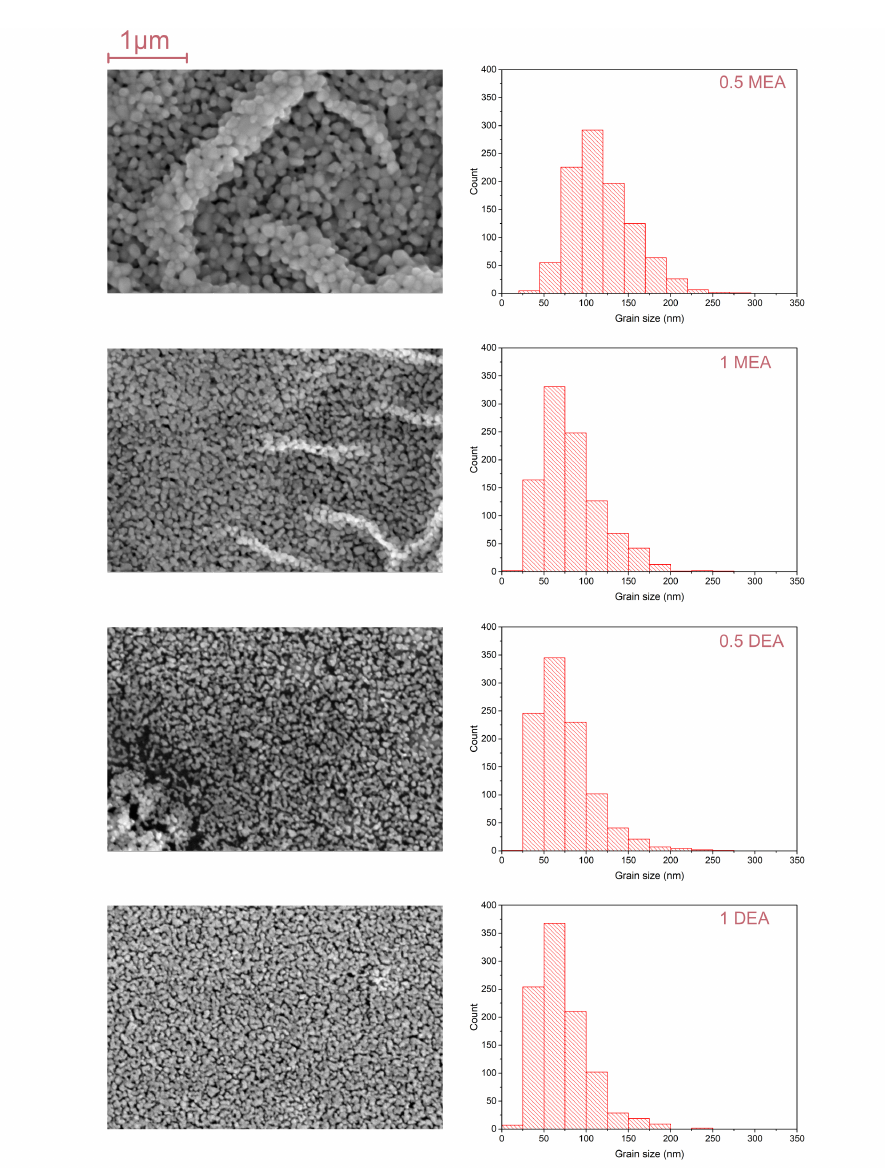
Figure 6. The SEM images and grain size distribution for ZnO layers grown on silicon.